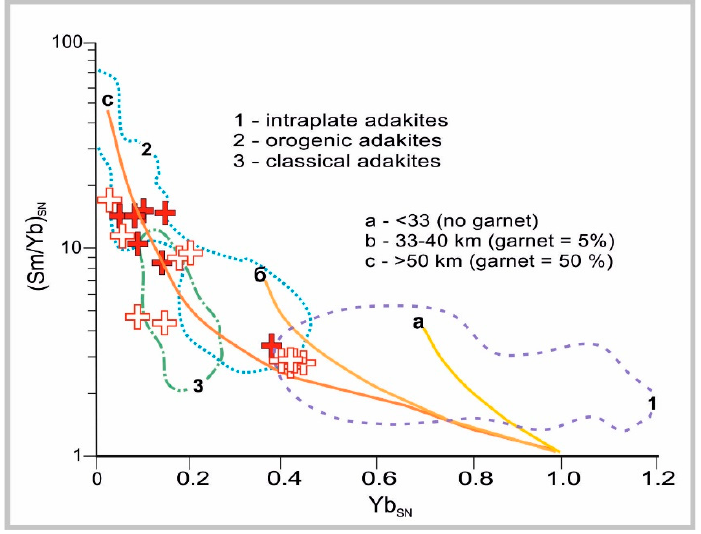
Figure 8. The location of granitoids of the adakite series of the EF MOOB framing on the diagram (Sm/Yb)sn–Ybsn [45]. The position of intraplate adakites (1)-represented by Mesozoic continental adakite rocks of the Northern China craton; orogenic adakites (2)-represented by adakites of the Central Andes, the Tibetan plateau and the Dabie orogen; classical adakites (3). Elements are normalized to the composition of MORB according to [53]. See the legend in Figure 2.